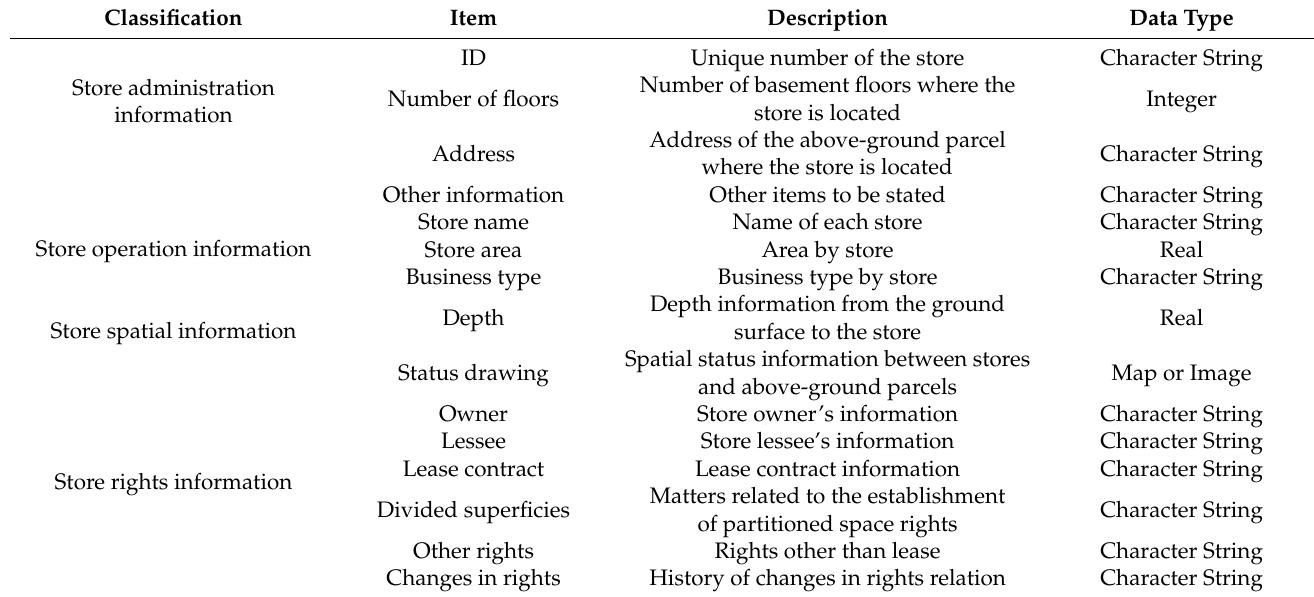
Table A2. Store class attribute